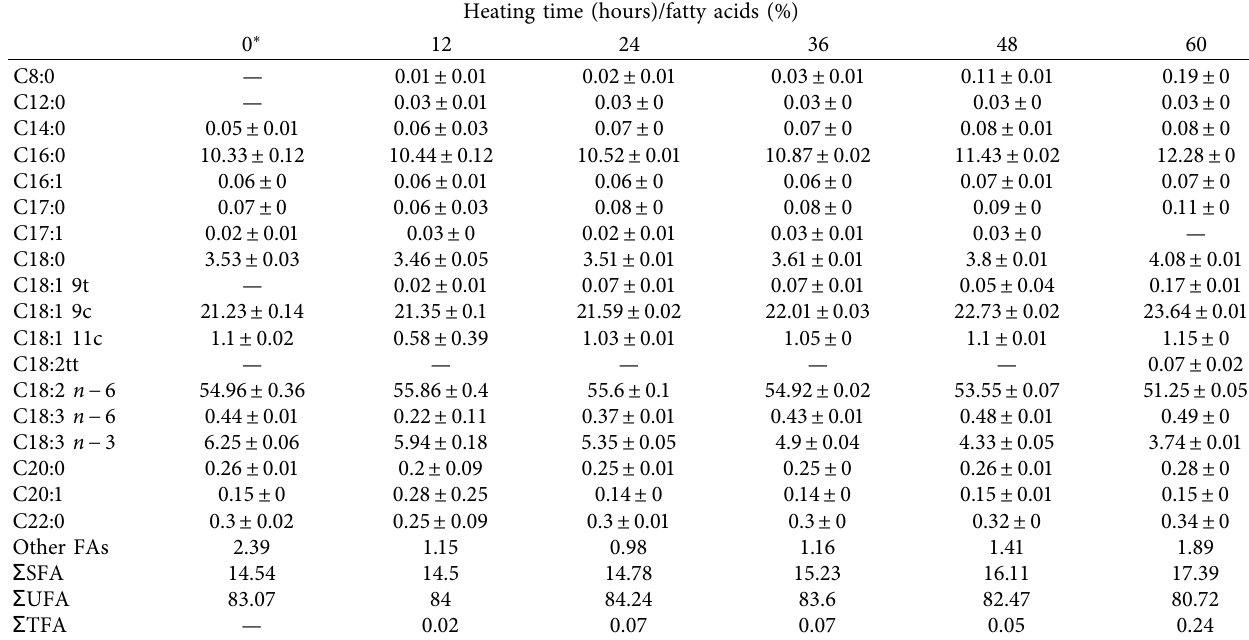
Table 5: Variation of fatty acids of soybean oil under 210 ° C heating temperature at different heating times. Heating time (hours)/fatty acids (%)